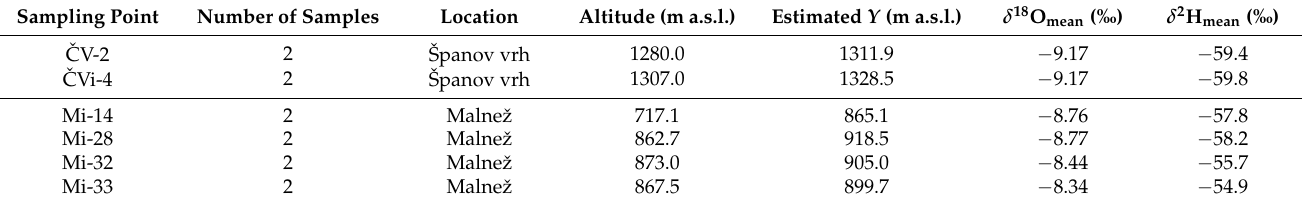
Table 3. Mean values of δ 18 O and δ 2 H and the altitude of the small springs in Španov vrh and Malnež